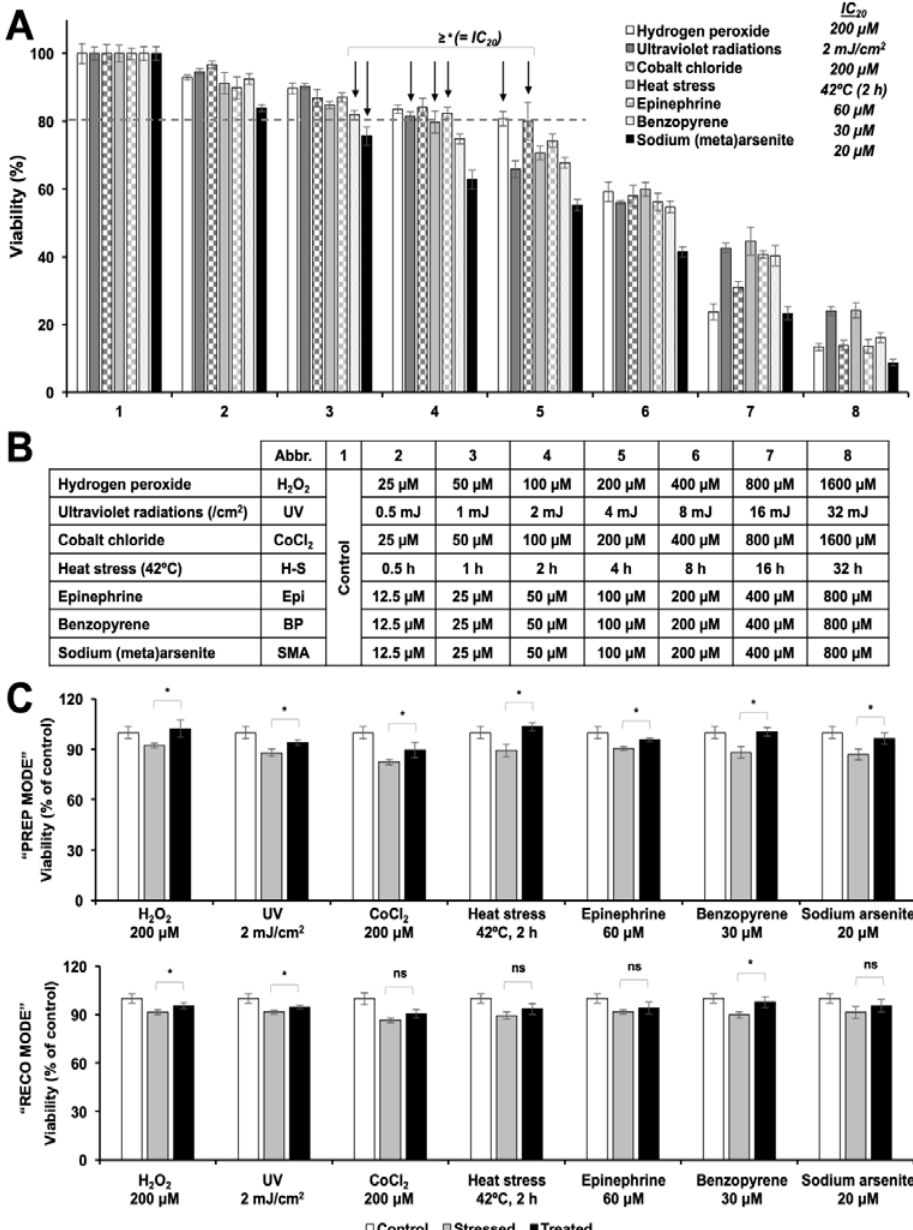
Figure 1. Anti-stress screening of resveratrol in C6 cells. ( A ). Dose-dependent toxicity of chemical stresses listedin( B )andidentificationoftheirIC 20 dosesusing3-(4,5-dimethylthiazol-2-yl)-2,5-diphenyltetrazolium bromide (MTT)-based cell viability assay. ( C ). Stress protection screening assay showing the anti-stress potential of resveratrol in C6 cells in pretreatment (PREP-defined by 24 h resveratrol pre-treatment followed by stress and recovery in resveratrol supplemented medium) and recovery (RECO-defined by stress followed by recovery in resveratrol supplemented medium) modes. Small but significant protection against all stresses was observed in PREP mode. RECO mode revealed protection against H2O2, UV and Benzopyrene